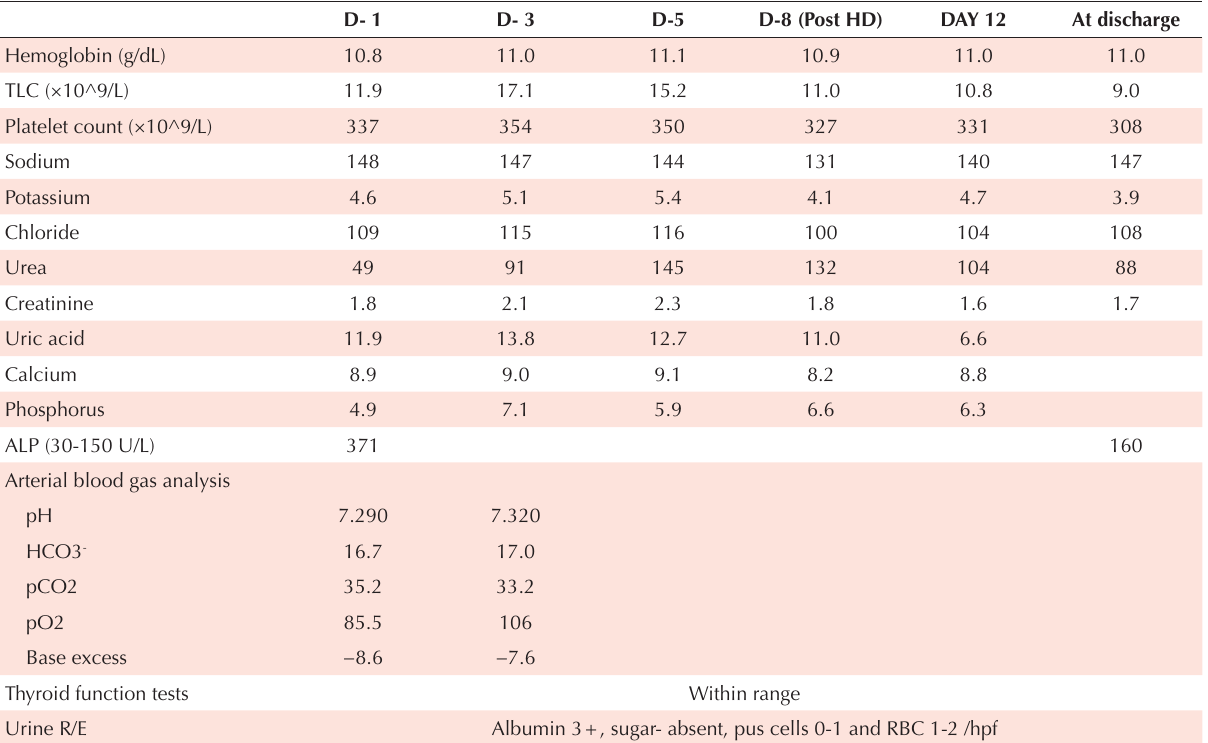
Table 1 . Laboratory investigation during hospital stay